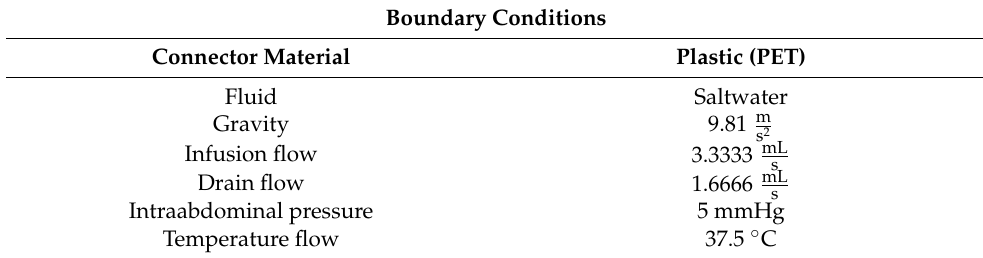
Table 2. Boundary conditions for numerical simulation.